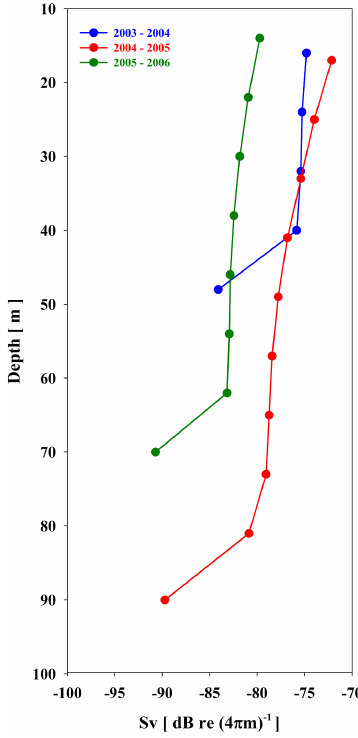
Fig. 3. Average backscatter strength profiles for the three deploy-